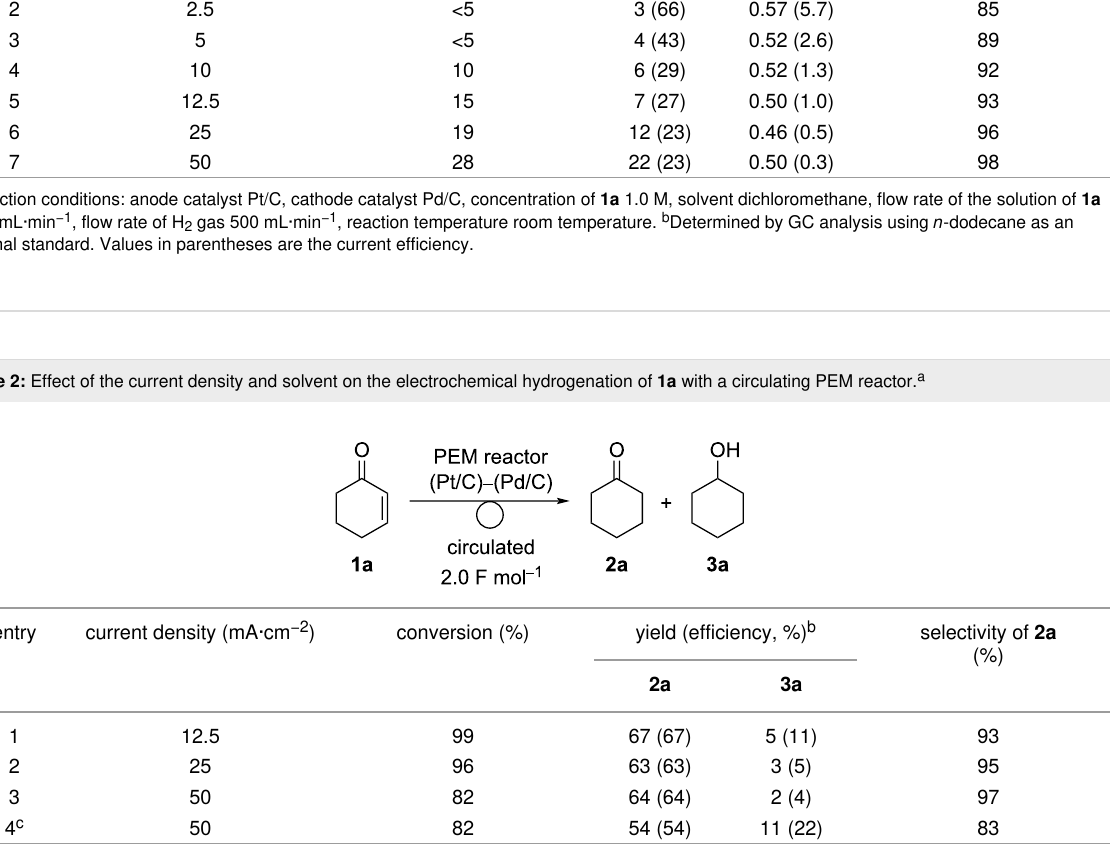
a Reaction conditions: anode catalyst Pt/C, concentration of 1a 1.0 M, solvent dichloromethane, flow rate of the solution of 1a 0.25 mL ⋅ min − 1 , flow rate of